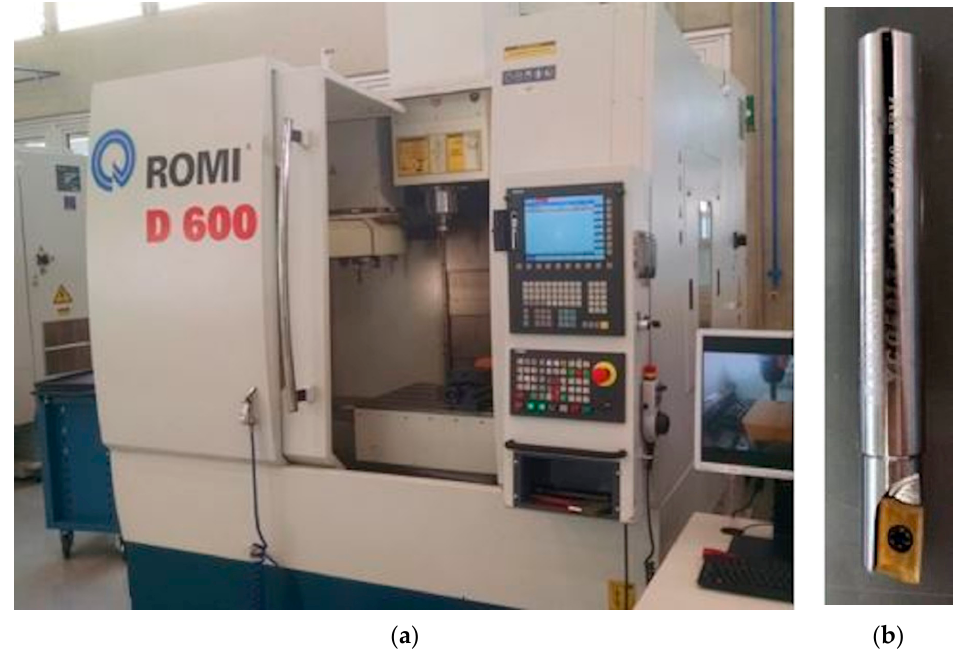
Figure 3. ( a ) ROMI D600 machining center and ( b ) KYOCERA tool used for milling.